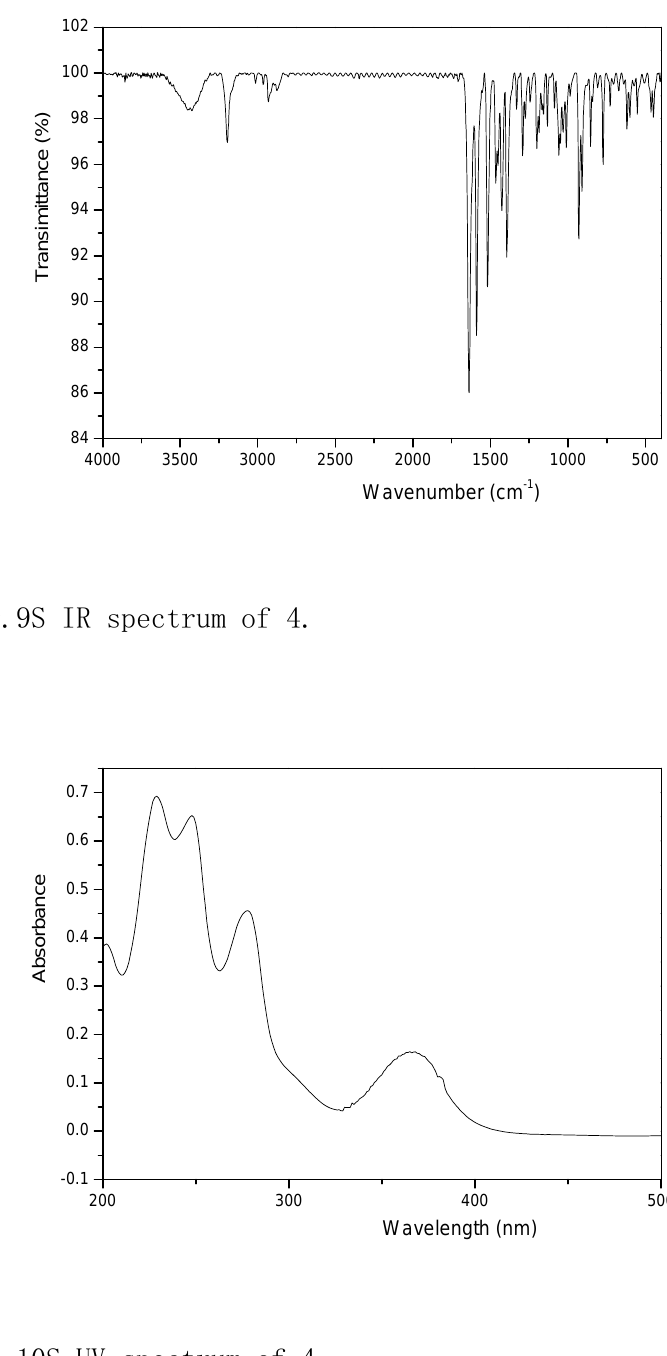
Fig.10S UV spectrum of